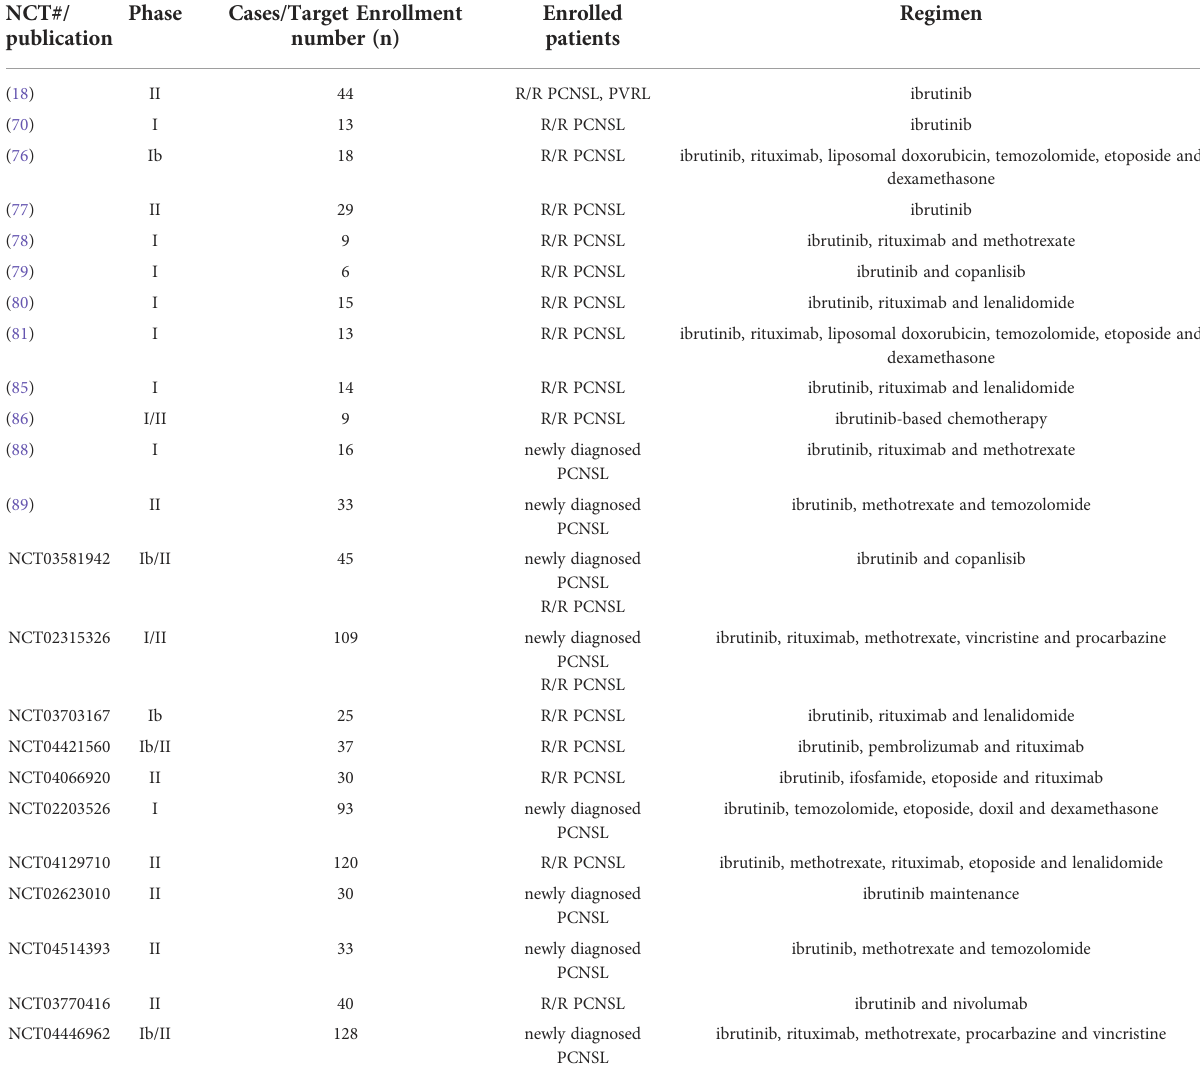
Table 1 Summary of published and ongoing ibrutinib monotherapy and combination treatments for R/R PCNSL or newly diagnosed